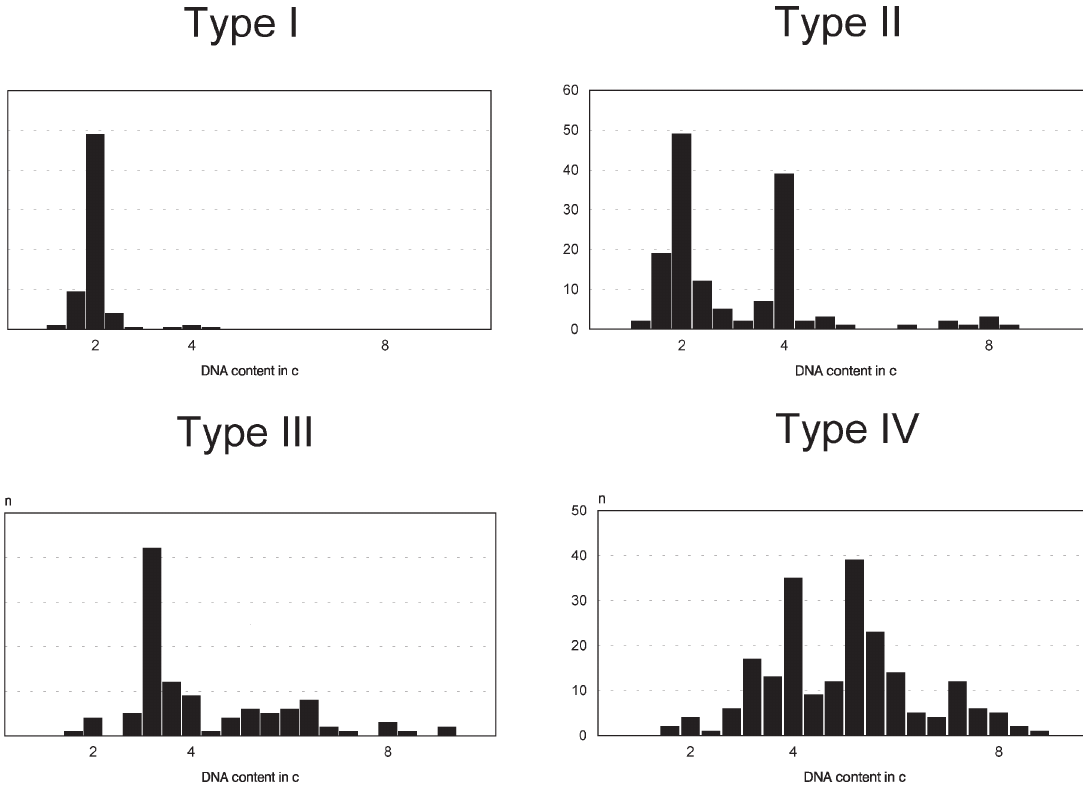
Fig. 2. DNA distribution pattern regarding the histogram